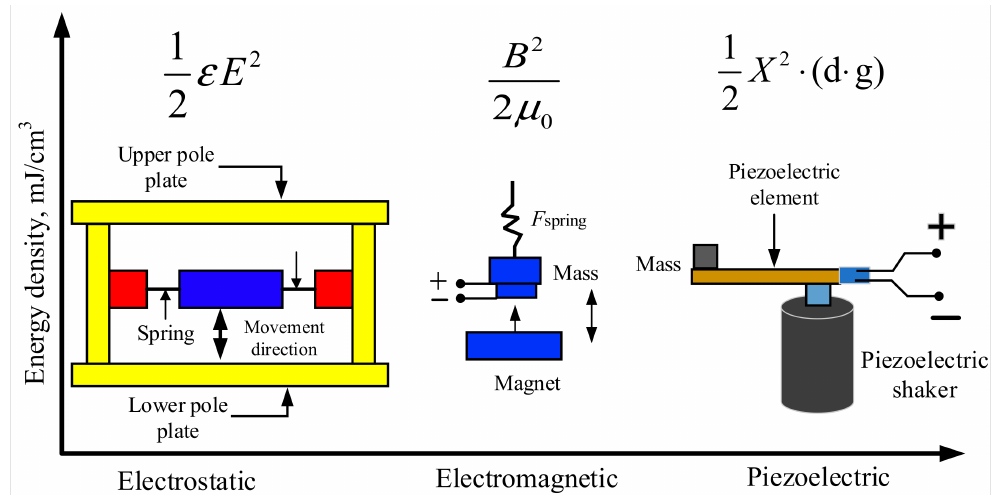
Figure 1. Comparison of the energy density for the three types of mechanical to electrical energy converters